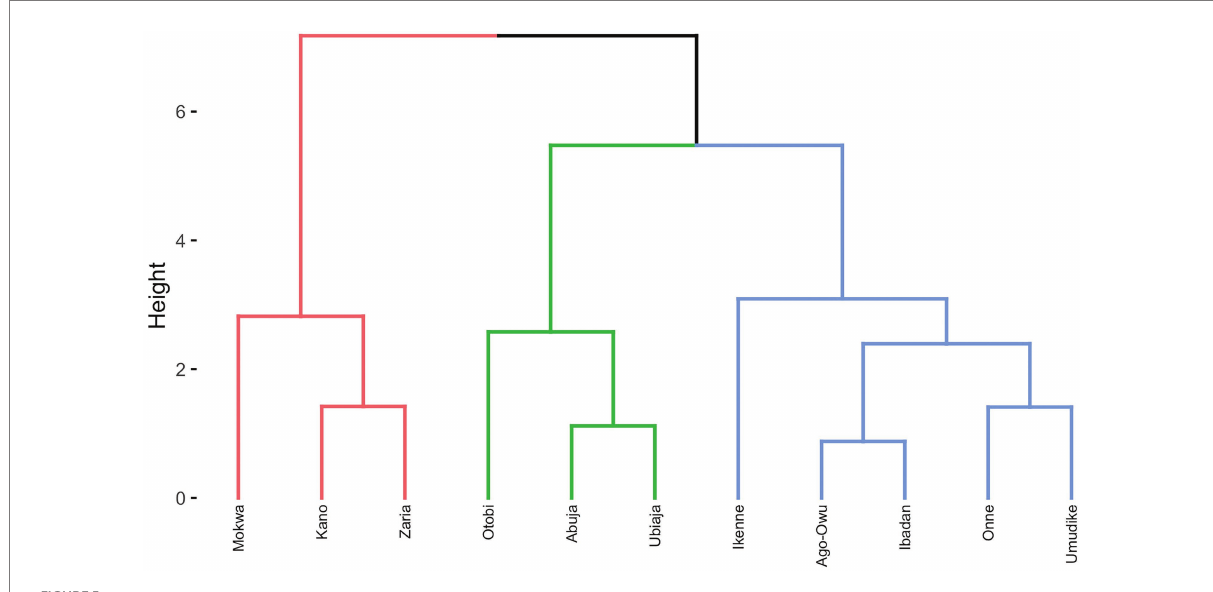
FIGURE 5 Dendrogram of 11 locations based on cassava fresh root yield using average rotated factor loadings from FA3 model and Ward’s D2 linkage method.